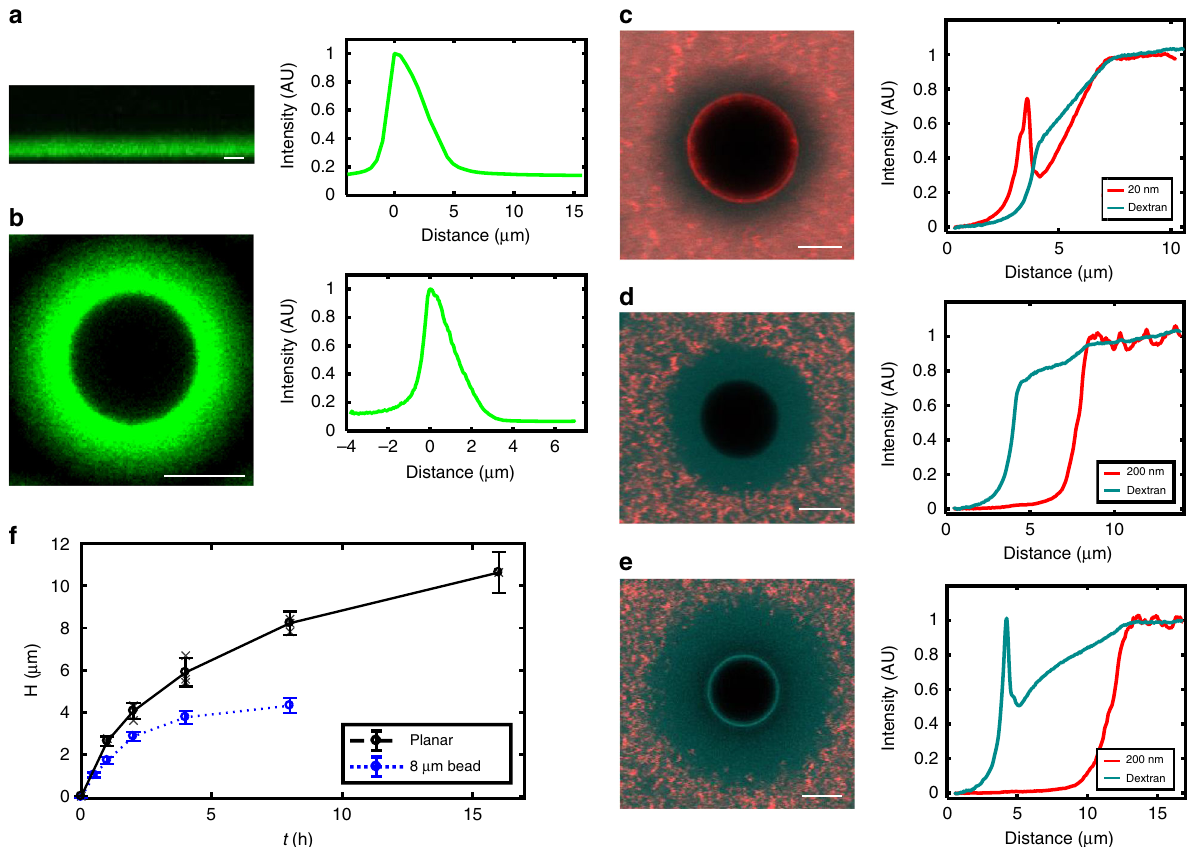
Fig. 2 Brush concentration pro fi les, nanoparticle sieving and growth dynamics. a Fluorescent pro fi le of a planar HA brush and its intensity pro fi le. b Fluorescent pro fi le of spherical brush and its intensity pro fi le. In both a , b the brush growth time is 4 h at 30 °C and the ionic strength 150 mM. c − e Cross-section of brush grown for 4 h on 8 µ m microsphere (left) and the particle penetration intensity pro fi le (right) for c 20 nm, 150 mM, d 200 nm, 150 mM and e 200 nm, 1.5 mM. Twenty nanometer particles show a distinct gradient within the brush while 200 nm particles remain excluded. Dextran (10 kDa, ~5 nm) is present in all cases (cyan) and shows an enhanced gradient in the low ionic strength swollen brush. f Dynamic growth of hyaluronan brushes generated by HA synthase (150 mM). The brush height reaches 2.62 ± 0.2 µ m (st. dev.) in just 1 h (planar) in high ionic strength conditions. After 16 h the brush is 10.6 ± 1.0 µ m (st. dev.). Measurements from individual brushes are shown in gray, averages and standard deviations are indicated in black. N _planar = 3 brushes, 12 regions per sample, except 16 h brush which is just one brush. The spherical brush plateaus at much earlier times (~5 h) at a fi nal height of 4.3 ± 0.4 µ m (st. dev.). N _spherical > 120 for spherical brush height measurements. All scale bars are 5 µ